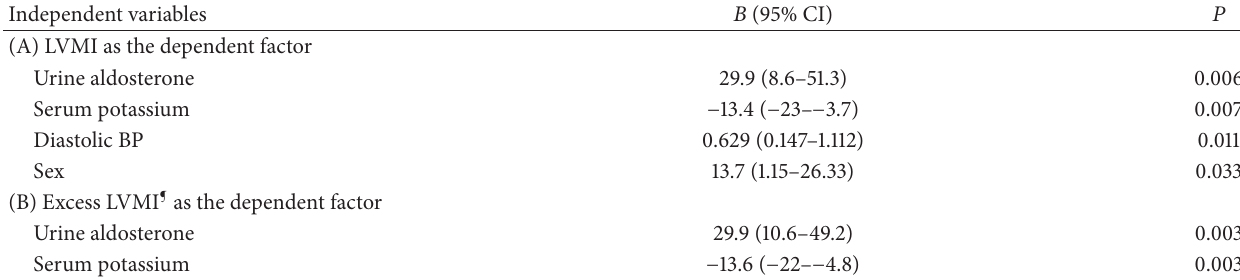
Table 5: Predictors for LVMI or inappropriate LVMI in patients with PA (groups 2 and 3). Independent variables 𝐵 (95%